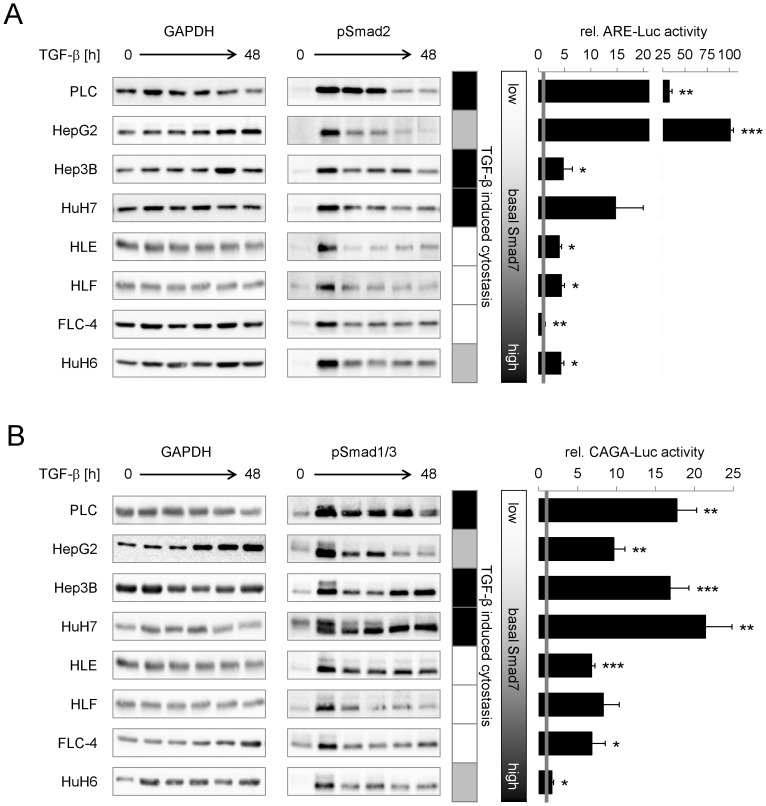
While Smad2 phosphorylation duration correlates to TGF-β and Smad7 expression, cytostatic responsiveness relates to CAGA-reporter-activation.HCC cell lines were treated with 5 ng/ml TGF-β for 0, 1, (3), 7, 24 and 48 h. (A) Left side: Western blot analysis of Smad2 phosphorylation and GAPDH expression. Right side: To evaluate TGF-β dependent transcriptional activity of Smad2, cells were transfected with plasmids carrying a luciferase gene under control of the activin response element (ARE) and additionally with a FAST-1 expression construct. Luciferase activity of cells treated with 5 ng/ml TGF-β for 9 h was correlated to untreated control samples. (B) Left side: Western blot analysis of Smad1/3 phosphorylation (1: upper/3: lower band); loading control GAPDH. Right side: TGF-β dependent transcriptional activity of Smad3 was evaluated 9 h after TGF-β treatment in cells infected with an adenovirus carrying a luciferase gene controlled by a CAGA response element. Treated samples were correlated to the corresponding untreated control. In the table, cell lines marked as black, show TGF-β induced cell death and growth inhibition whereas cells marked as grey mainly react with the latter one. The gradient from white to black displays increasing basal Smad7 expression levels. (C) Immunofluorescent detection of linker phosphorylated Smad3 in uninduced HCC-T cells. Red fluorescence indicates nuclear localization of pSmad3L. Blue staining indicates nuclei stained with DRAQ5. Significant differences are indicated as * p < 0.05, ** p < 0.01 and *** p < 0.001 (Student’s t test).